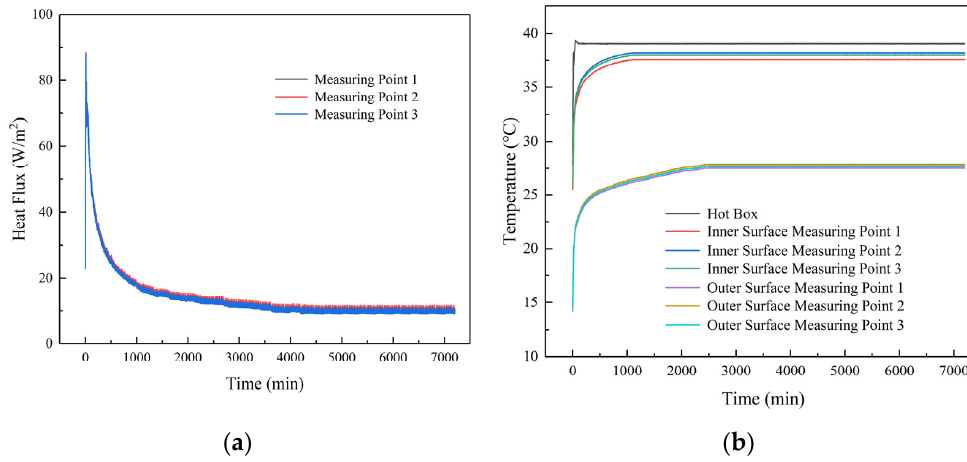
Figure 8. S-50XPS test data: ( a ) heat flux; ( b ) temperature.